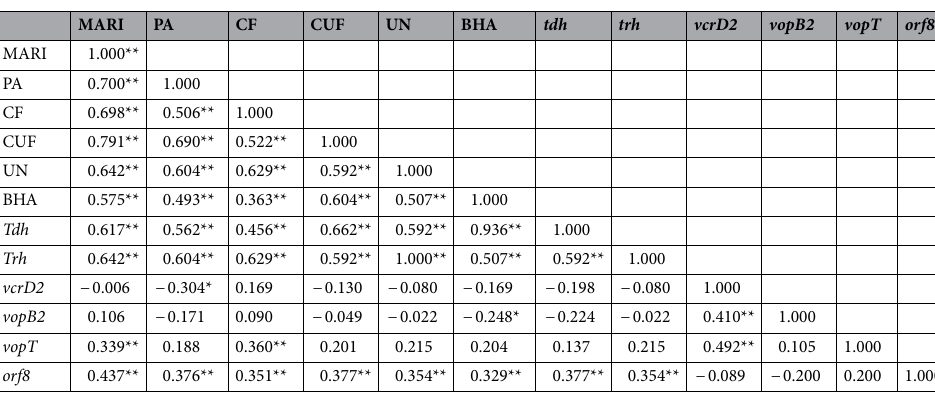
Table 3. Correlation of phenotypic and genotypic virulence of V. parahaemolyticus strains. MARI multiple antibiotic resistance index, PA protease activity, CF cellulose formation, CUF curli formation, UN urease + 2% NaCl activity, BHA beta hemolytic activity. **correlation is significant at the 0.01 level (2-tailed), *correlation is significant at the 0.05 level